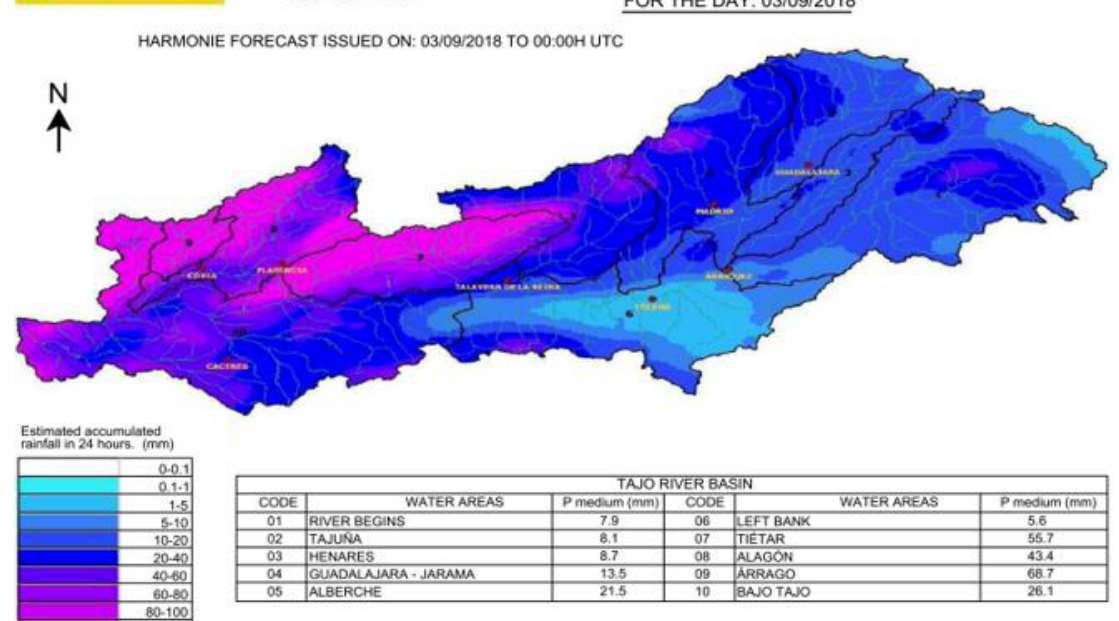
Figure 8. Rainfall forecasts on the day of the starting